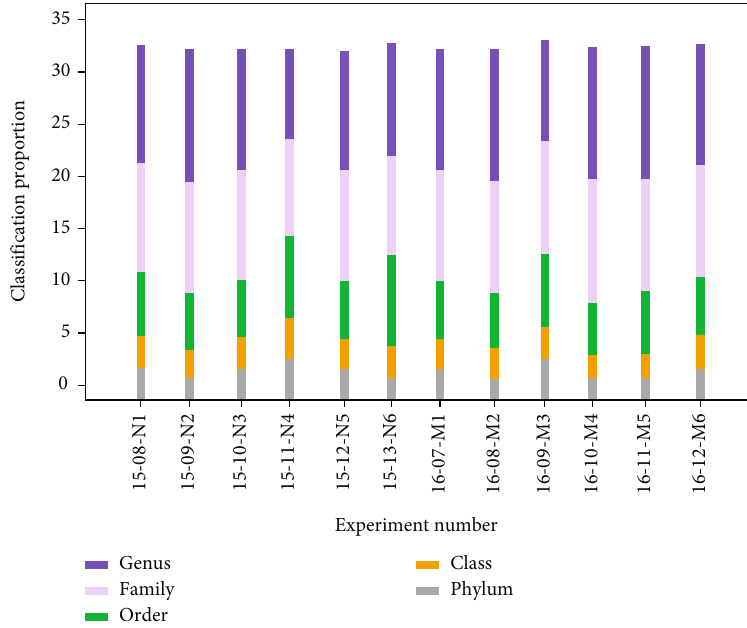
Figure 6: Annotation to statistics in sorting.